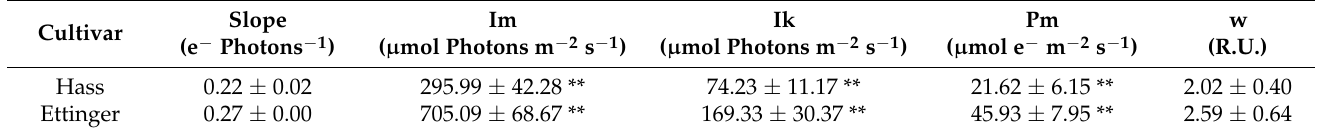
Table 2. Light response curve parameters for two avocado cultivars measured at room temperature conditions. Slope—linear slope at the beginning of each curve; Im—light intensity at the maximum photosynthetic activity; Ik—Light intensity at the transfer from photosynthetic efficient to photopro- tective efficient activity; Pm—maximum photosynthetic activity; w—photoinhibition magnitude. N =6, error represents standard error of the mean. Statistical significance difference between the two cultivars was determined at p <